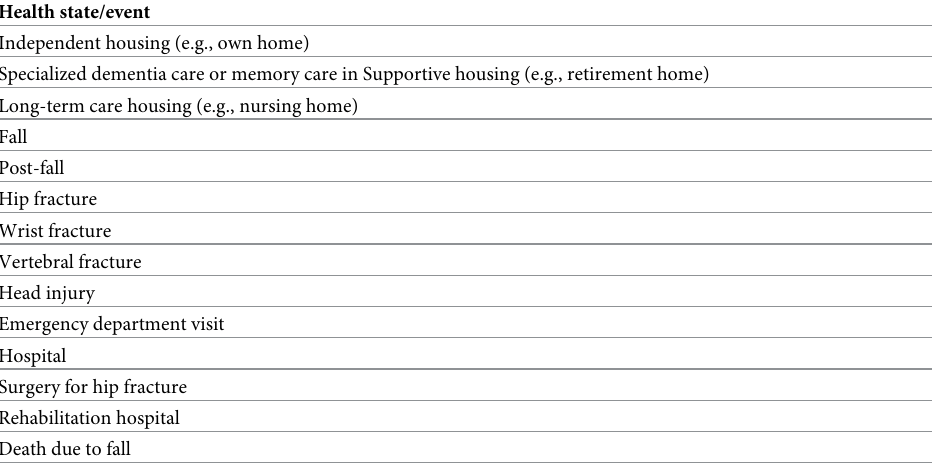
Table 6. Included health states/events as selected by Delphi